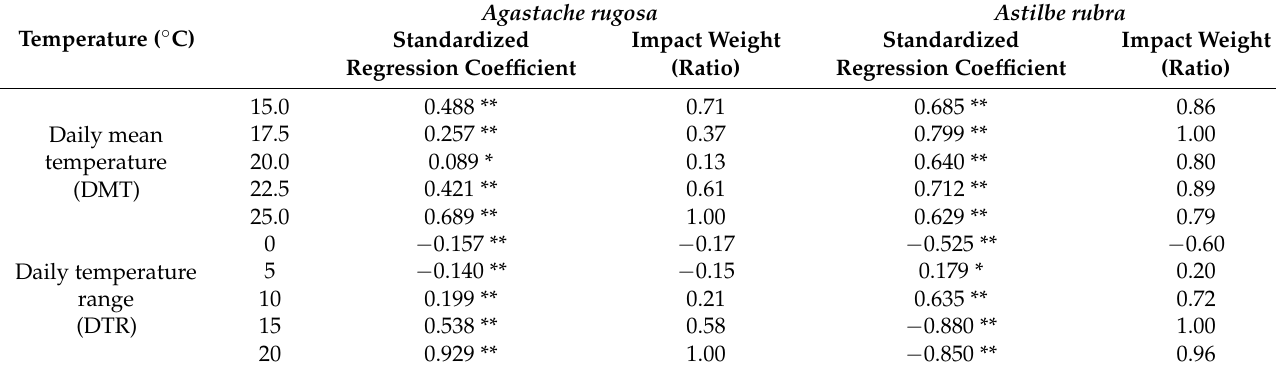
Table 1. Multiple regression analysis of the cumulative germination percentage and the cumulative daily mean temperature (DMT) and daily temperature range (DTR) in Agastache rugosa and Astilbe rubra . The results of all regression analyses showed that the p -value was less than 0.001 through the F-test. “Impact weight” was converted based on the largest absolute value of the standardized regression coefficients. The minus regression coefficient means a negative linear relationship between the cumulative germination percentage and the cumulative DTR. (* p < 0.05; ** p < 0.01; n = 160). Agastache rugosa Astilbe rubra Temperature ( ◦ C) Standardized Impact Weight Standardized Impact Regression Coefficient (Ratio) Regression Coefficient